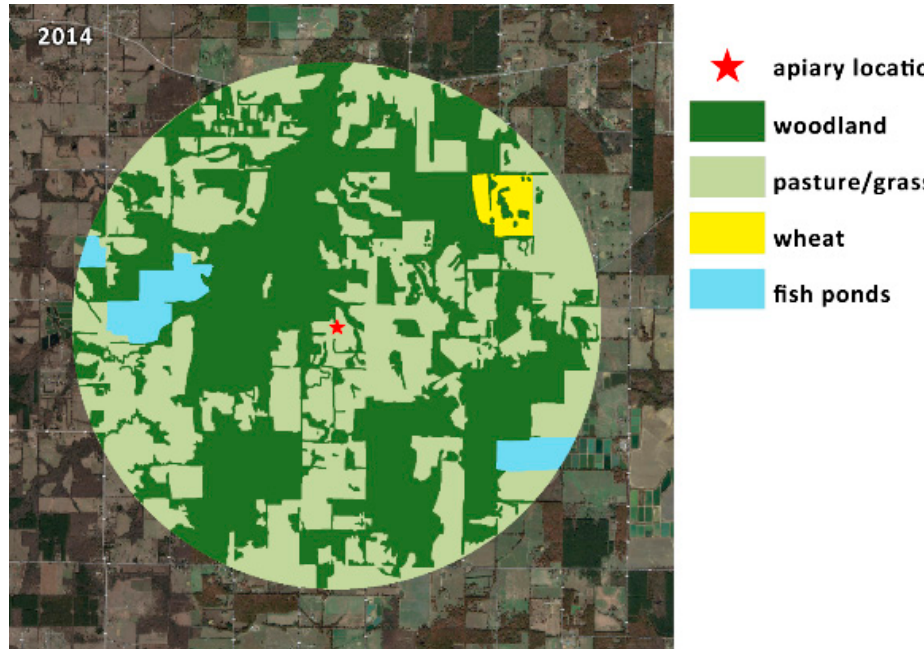
of Arkansas, USDA Farm Services Agency).